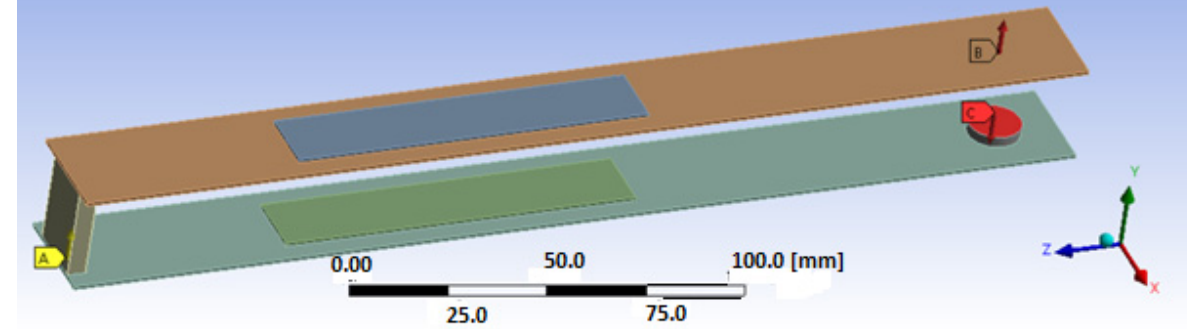
10 of 21 Figure 6. Comparison of the phase portraits for the model of the coupled magnetic piezo-harvester by different beams space and frequency excitation (upper beam -blue line, lower beam – orange line) 4. The Computational Model of the Coupled Magnetic Beam Structure In order to verify the values of the optimization parameters calculated in the previous section, the numerical calculations of the magnetic coupled piezoelectric harvesters with a homogenized material are described in this section. Taking into account the above fact, in the first step, the FE model of piezo-composite composed of a single active layer, two electrode layers, and two Kapton layers, as it is shown in Figure 2, is designed by using the homogenization technique, such as the representative volume element (RVE), in order to obtain better mechanical and electrical properties of this element (see Table 1). Overall, it is achieved by considering a stress-strain effect in the laminate structure as well as the fact, that the normal plane section of the reference surface of the laminated shell remains plane after the deformation, but is not necessarily normal to the deformed reference sur- face that is the main feature of the first-order shear theory (FOST). Then, according to this theory described in detail in [49] only displacements, forces applied to the structure and electrical potentials are enough to increase the computational efficiency model as well as obtain a higher value of voltage generated by the piezo-element. In the next step, the process of discretization of the considered structure is performed using the RVE technique. Then, according to this method, the piezoelectric fiber layer with a homogenized material is modeled using a Solid 226-node coupled brick element, while the electrode and Kapton layers of the harvester are modeled using an 8-node coupled- brick element, Solid186. On the other hand, other passive elements, such as the upper